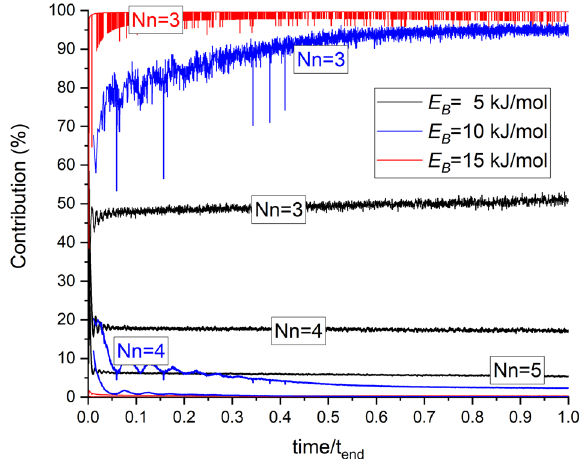
Fig. 3 Contribution of the different types of sites to the crystal dissolution rate. N n is the number of nearest neighbors: N n = 3 for kinks, N n = 4 for steps, N n = 5 for terraces. Random fl uctuations are due to the stochastic nature of the KMC method.